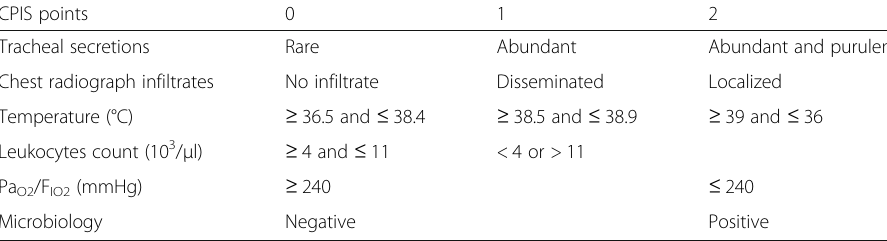
Table 1 Clinical pulmonary infection